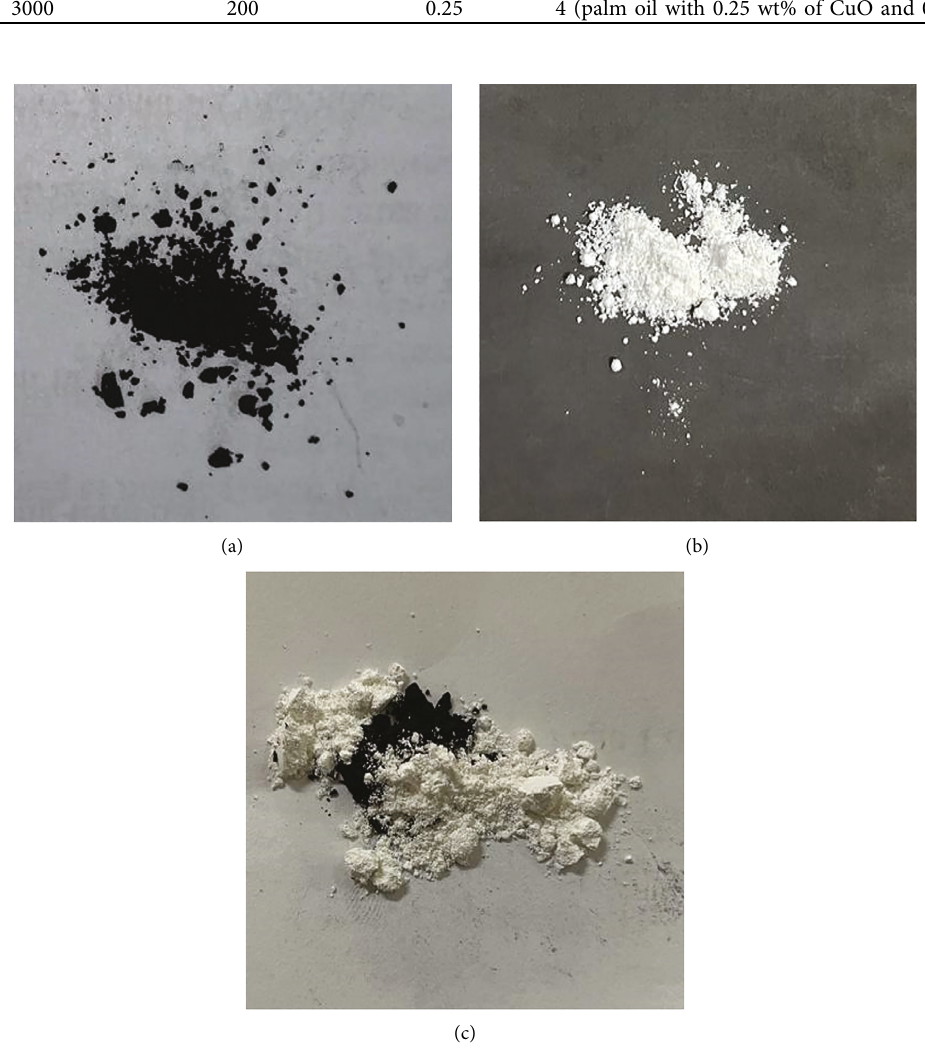
Figure 5: (a) 0.5wt% of CuO, (b) 0.5wt% of TiO 2 nanoparticles, (c) hybrid (0.25 wt% of CuO +0.25wt% of TiO 2